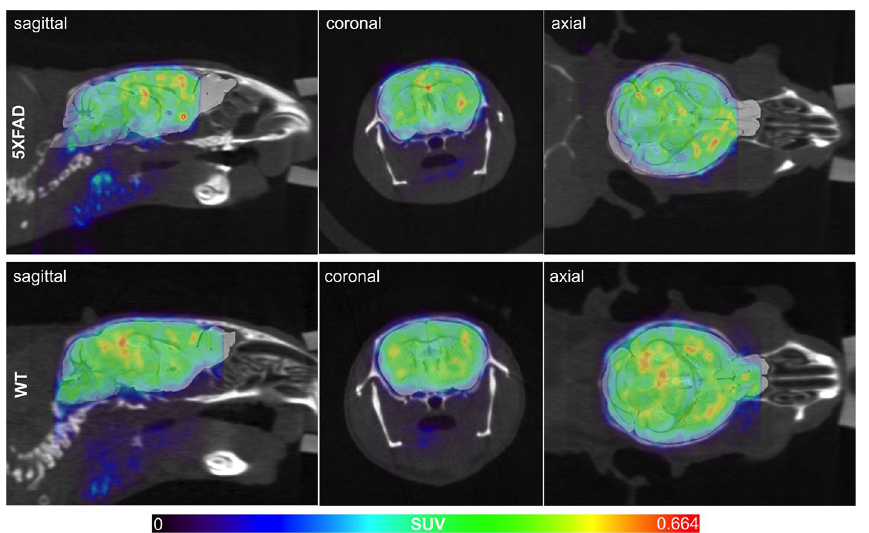
Figure 2. [ 99m Tc]HMPAO Single Photon Emission Computed Tomography/Computed Tomography (SPECT/ CT) images are co-registered with a mouse-specific (warped) standard MR brain in sagittal, coronal, and axial planes for representative 5XFAD (top) and WT (bottom) mice. A similar distribution of [ 99m Tc]HMPAO radiotracer was observed between 5XFAD and WT mice. SPECT images were set to a common scale of 0–0.663 standardized uptake value (SUV)